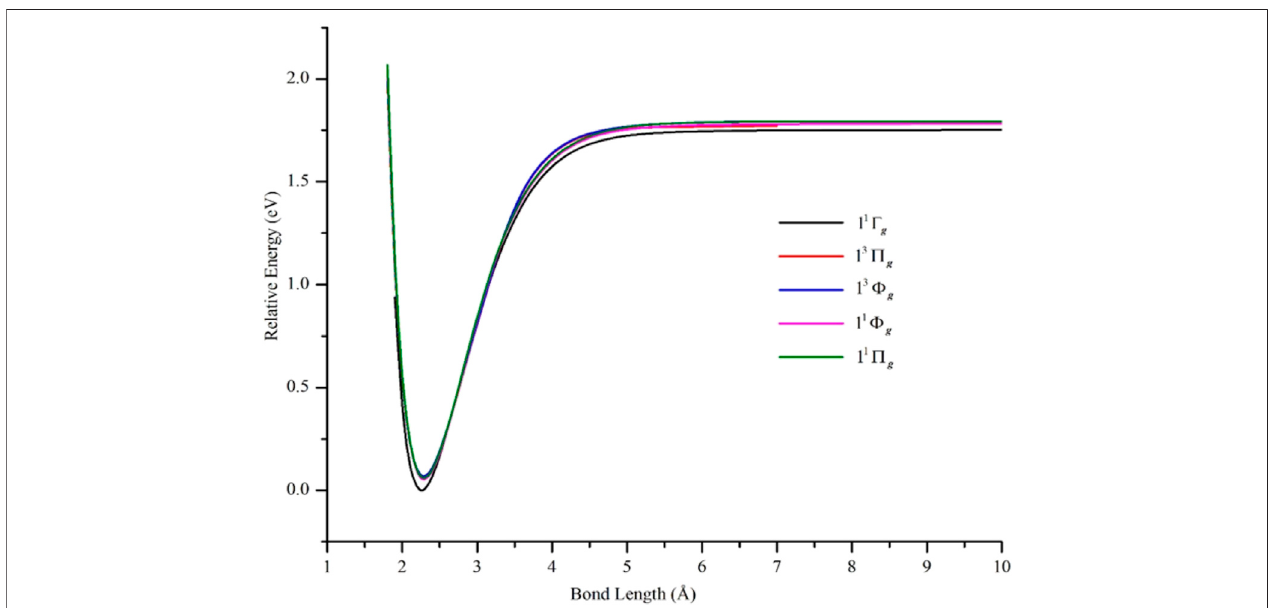
FIGURE5| PECsoflow-lying δπ – holeelectronicstatesofNi 2 computedattheGVVPT2leveloftheoryusingthecc-pVTZbasissetcomparedwiththePECoftheX 1 Γ g ground term. All energies are plotted relative to the lowest energy value of the X